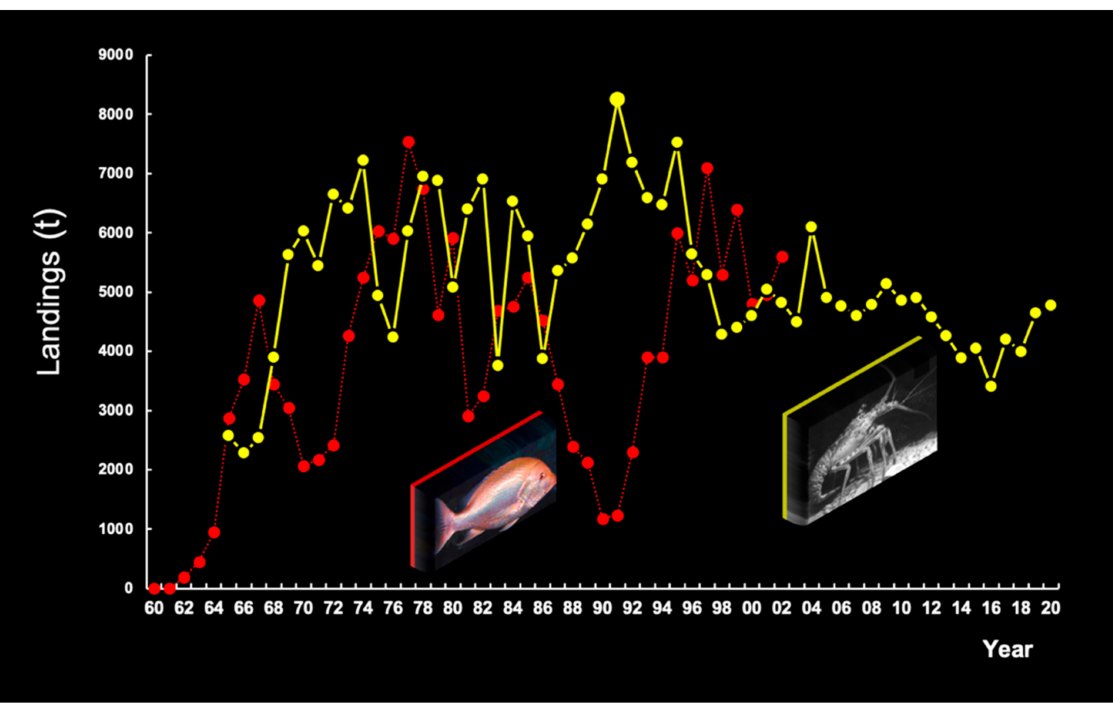
Figure 11. Annual landings of Brazilian form of Panulirus argus (Latreille, 1804) and red snapper ( Lutjanus purpureus Poey, 1866) with a 3-year lag in Great Amazon Reef System (GARS) and in Northeast (NE).